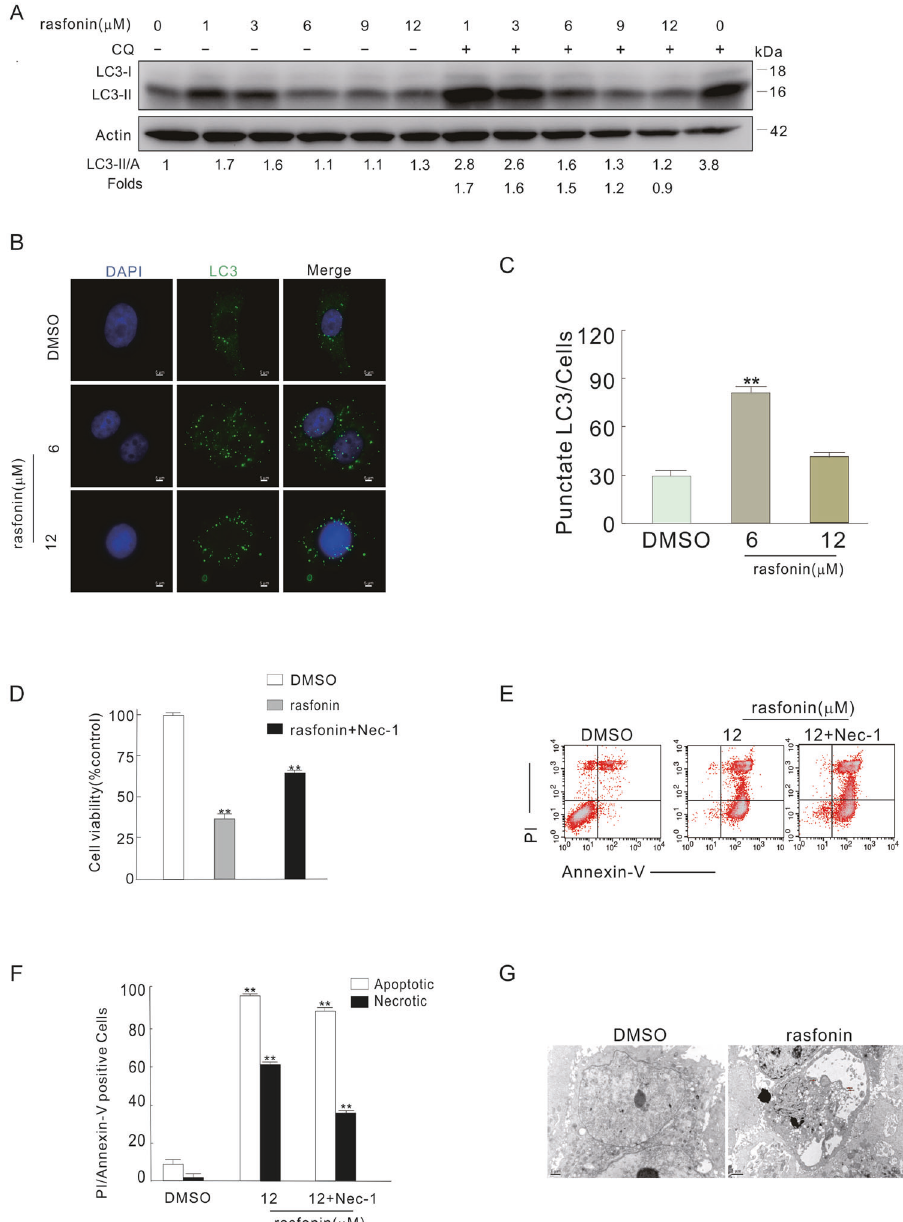
Fig. 1 High concentration of rasfonin inhibited autophagy and induced necroptosis. A ACHN cells were treated with rasfonin (0 – 12) μ M for 4 h, the cells were lysed and subjected to immunoblotting with the antibodies indicated. Actin was used as a loading control. B, C ACHN cells were split onto coverslips, cultured overnight, following rasfonin (6 or 12 μ M) for 6 h. the cells were fi xed with 4% paraformaldehyde, immunostained with anti-LC3 antibody and visualized by fl uorescence microscopy The number of the punctate LC3 in each cell was counted, and at least 50 cells were included for each group. Data representing the mean ± S.D. were shown in graph. D ACHN cells were treated with rasfonin (12 μ M) in the presence or absence of necrostatin 1 (Nec-1, 30 μ M) for 12 h; cell viability was analyzed by MTS assay as described in Materials and Methods. E , F ACHN cells were treated with rasfonin (12 μ M) alone or together with Nec-1 (30 μ M) for 6 h, the induced apoptosis and necrosis were determined by fl ow cytometry. Apoptotic: AV-positive and PI-negative; necrotic: PI-positive. The data are presented as mean ± S.D. from three independent experiments. The double asterisk denotes the group is statistically different from the control groups ( P < 0.01). G Electron microscopy was performed in ACHN cells following treatment of rasfonin (12 μ M) for 6 h as described in “ Materials and methods ” . Arrow: vesiculation of cytoplasmic organelle; Double Arrows: rupture of the plasma membrane. Similar experiments were repeated at least three times. rasfonin-induced autophagy, we transfected wild type (WT) EGFR the results with ge fi tinib, we knocked down EGFR in the cells. In and the kinase motif mutant (K721A) in HEK293T cells, which contrast to the mock-control, rasfonin failed to inhibit autophagy have a much lower expression of the receptor than ACHN in EGFR-deprived cells (Fig. 5B, C). (Supplement Fig. 2C). As expectedly, rasfonin failed to inhibit A previous study revealed that EGFR with a mutated kinase autophagy in K721A-transfected but not WT EGFR overexpres- domain initiates the autophagic process upon serum starvation sing cells (Fig. 5D-F). [37]. To further determine EGFR signaling in the regulation of Cell Death Discovery (2022)